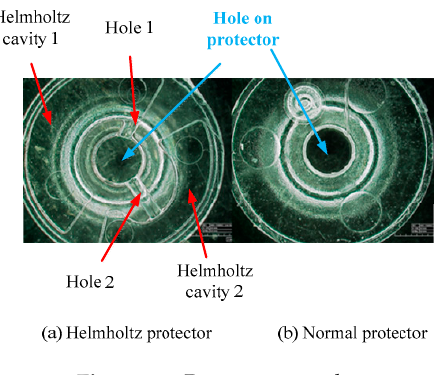
Figure 23. Protector sample.